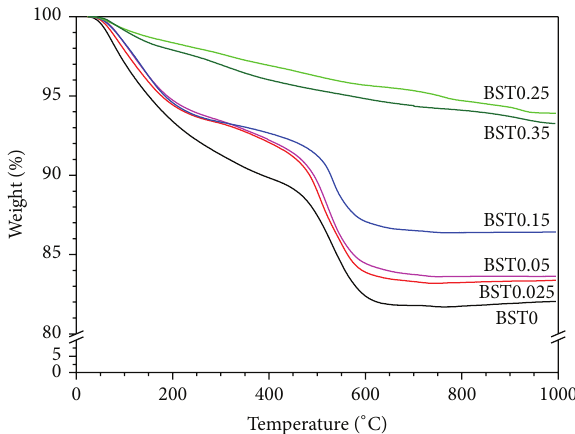
Figure 1: The TG curves of dried-gel BST powders with various Na